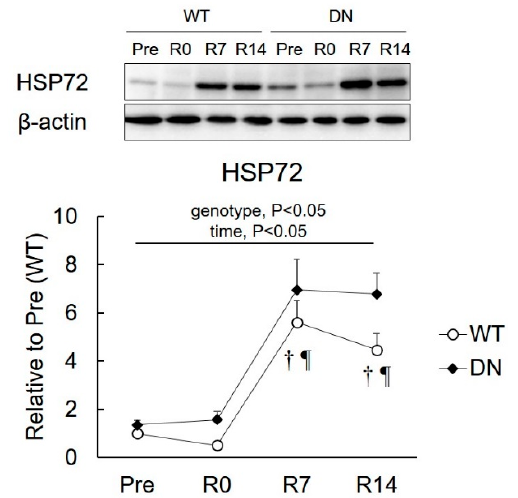
Figure 6. Changes in the 72-kDa heat shock protein (HSP72) expression after 14 days of hindlimb unloading, and at 0, 7, and 14 days of reloading. Representative immunoblots are shown. Values are means ± SE. Statistical results of two-way ANOVA (genotype, time, and genotype × time) are described in the Figure. †, significant difference from Pre independent of genotype. ¶, significant difference from R0 independent of genotype.